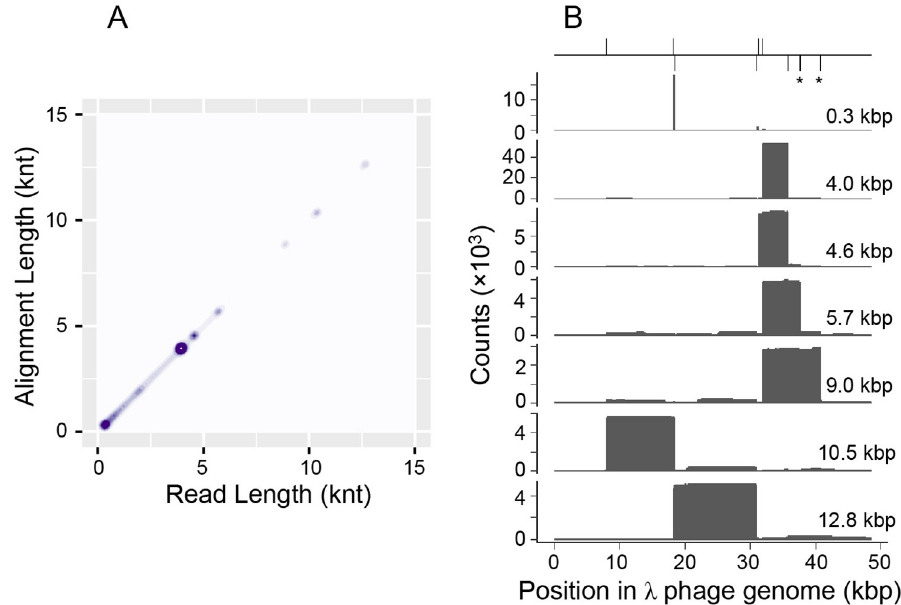
Fig 3. Identification of dsDNA amplicons in a T7 SDA reaction. Data are shown for the reaction of Δ 28 gp5 and Nt. BbvCI. (A) Kernel density estimate plot of read length against alignment length. Reads were filtered to have average basecall quality greater than 10. Only one alignment is considered per read. (B) Coverage maps of reads with specified lengths. At top is a diagram showing recognition sites for Nt.BbvCI in the λ phage genome. Two additional sites of sequence GCTTAGG are denoted with